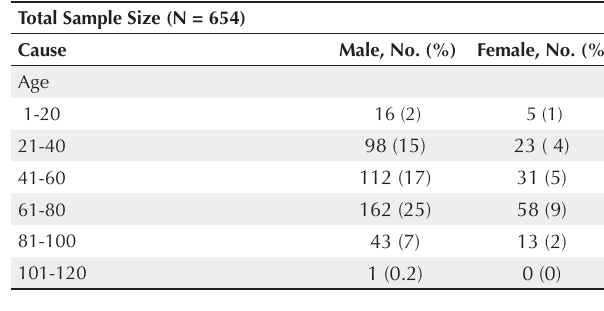
Table 2. Distribution of Deaths by Age and